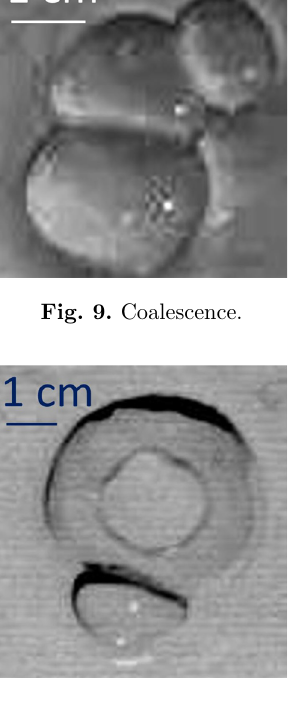
Fig. 10. Explosion.